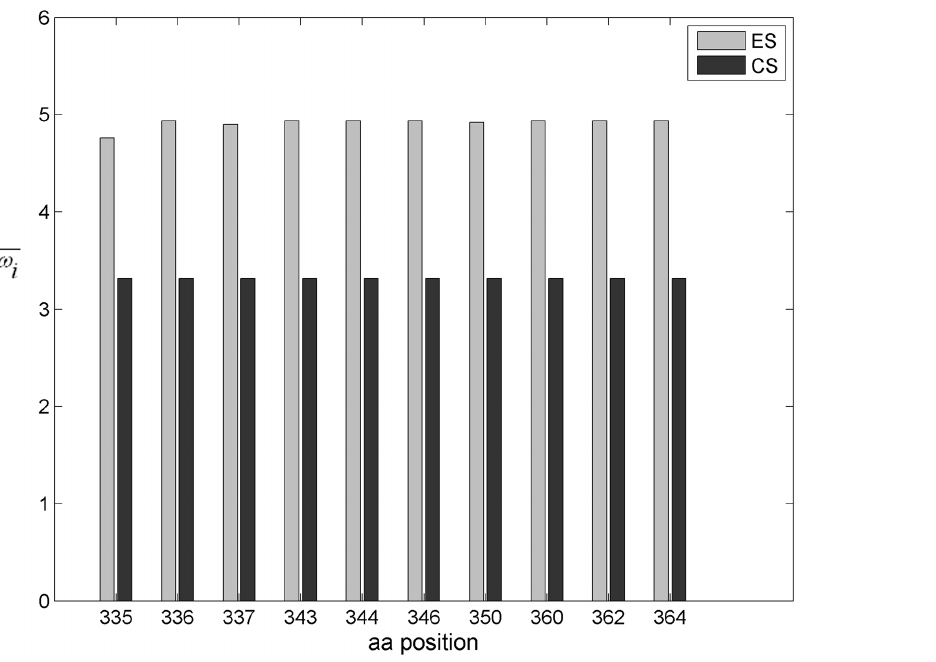
Figure 3. Strength of positive selection of sites in the C3 region during the early and chronic disease stages. The strength of positive selection ( v ) for each amino acid site is reported in the y axis. Sites are reported in the x axis. Amino acids numbering is according to HXB2 sequence. Grey and black bars show the strength of positive selection of each of the sites for the early infection stage (ES) and the chronic infection stage (CS), respectively. Statistical significance of the difference between the two series: p=0.00016.